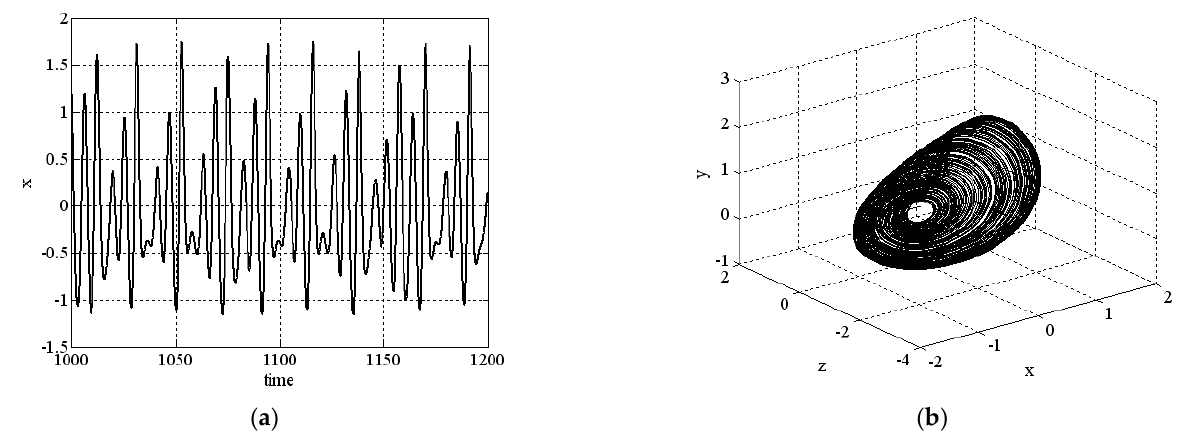
Figure A2. Results for δ (the saddle-focus index) of fixed point